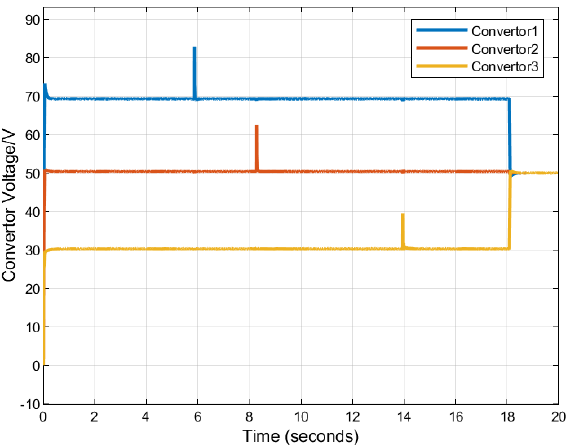
Figure 16. Output voltage of each converter.